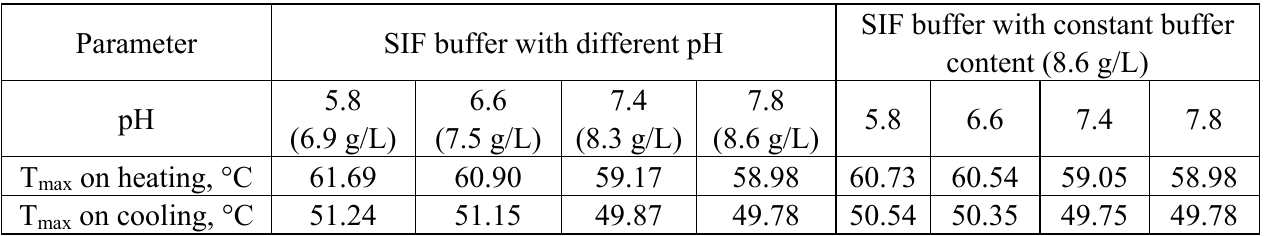
Table 8. Peak temperatures (T different